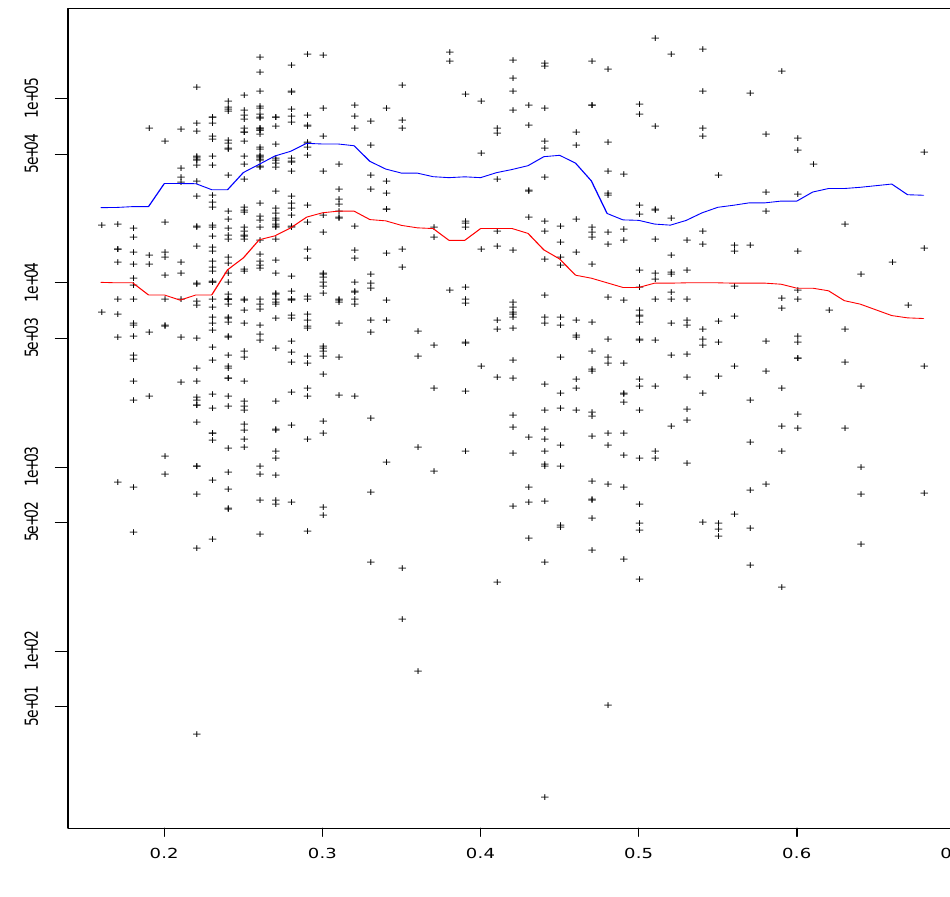
(·) (red) and scale function ˆ b (·) n n